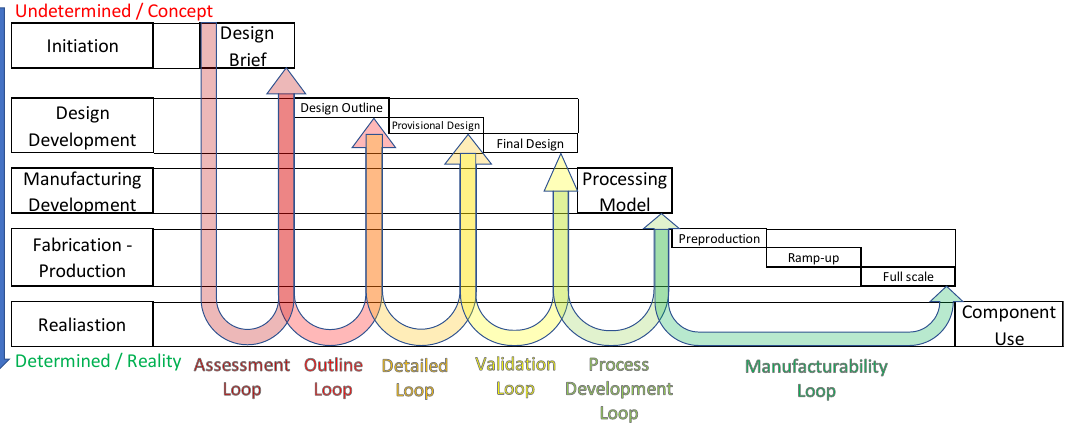
Figure 4. Feedback loops, adapted from [2].